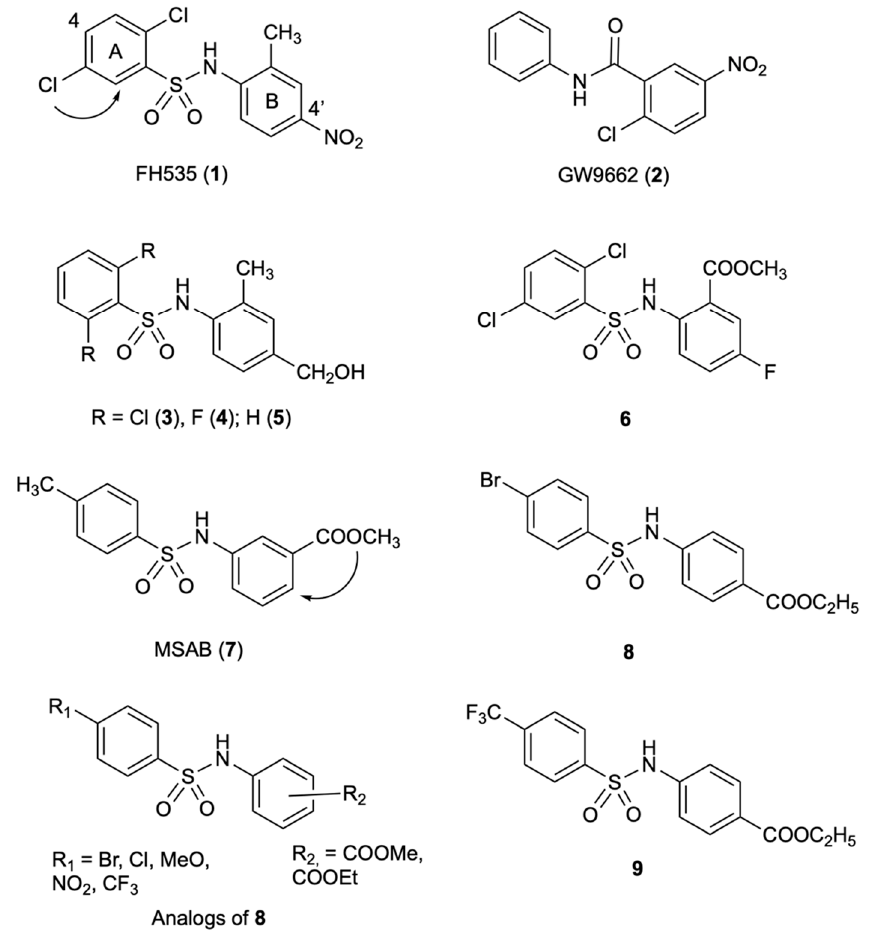
Figure 2. Chemical structures of sulfonamides 1 – 9 inhibitors of the Wnt/ β -catenin